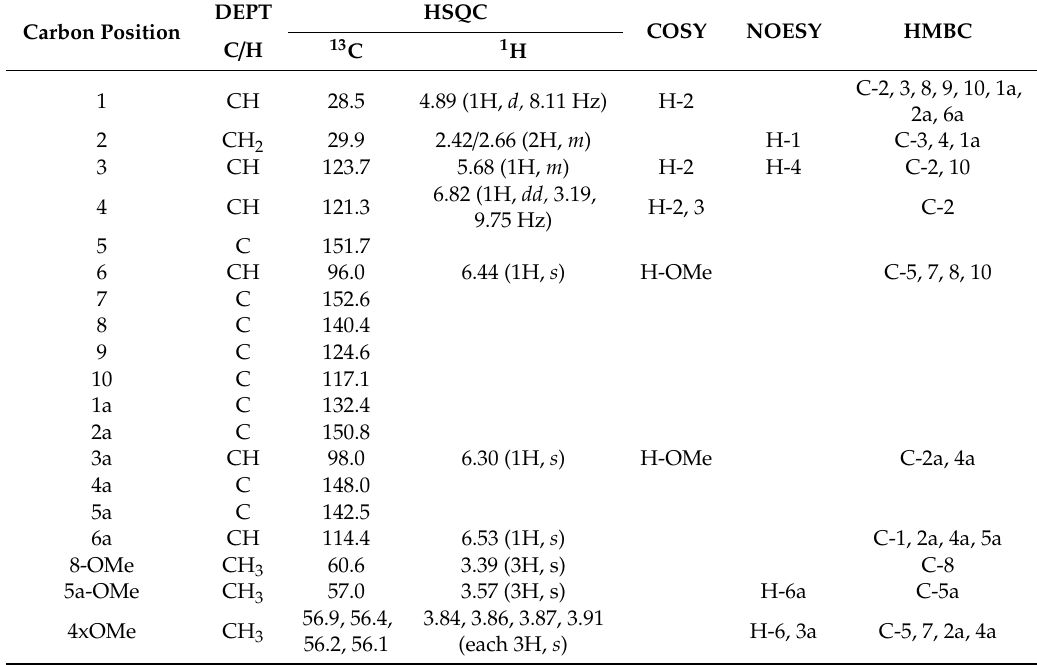
Table 1. 1 H (600 MHz), 13 C (150.9 MHz), DEPT, COSY, NOESY, and HMBC NMR data (CDCl 3 ) of pachypostaudin B ( 2 ).